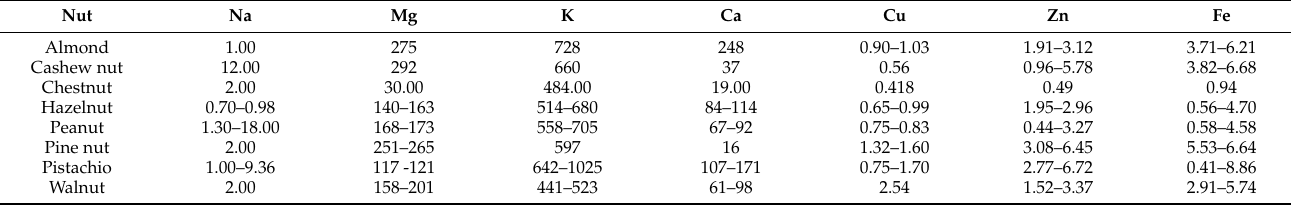
Table 3. Mineral contents (mg/100 g) of selected nuts (source: